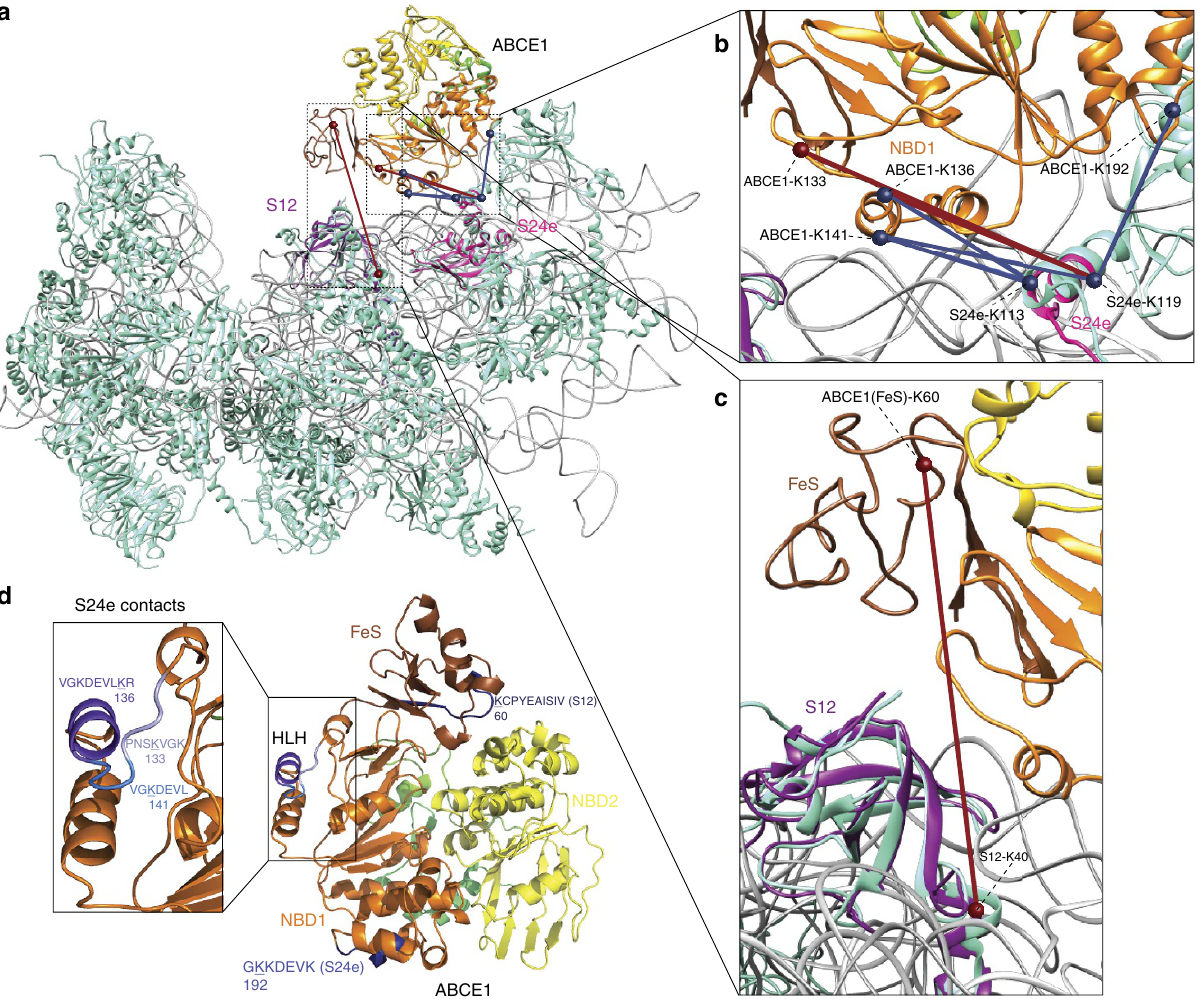
Figure 2 | Architecture of the PRC (30S (cid:2) ABCE1 (cid:2) AMP-PNP) mapped by XL-MS. ( a ) The orientation of ABCE1 in the PRC based on the identified inter cross-links with the archaeal ribosomal proteins S24e (pink, b ) and S12 (dark magenta, c ), depicted in blue and red lines. Blue lines indicate cross-links with a length o 30Å and red lines cross-links 4 30Å. Identified inter cross-links were certified using an in silico model of the S. solfataricus 30S constructed by aligning the homology models of the archaeal ribosomal proteins to the small ribosomal subunit from S. cerevisiae (pdb: 3U5G/F, r-proteins: cyan, rRNA: grey) and positioning ABCE1 according to the cryo-EM map of the rescue/pre-recycling complex (pdb: 3J16). ( d ) The major contact area of ABCE1 towards the 30S primarily locates in the helix–loop–helix region